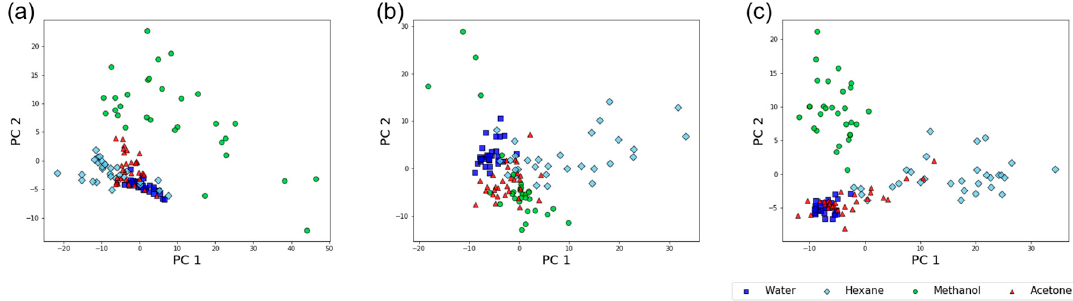
Figure 5. PCA score plots for TFRs datasets. Measurement data were obtained by ( a ) Protocol-1, ( b ) Protocol-3, and ( c ) Protocol-5.